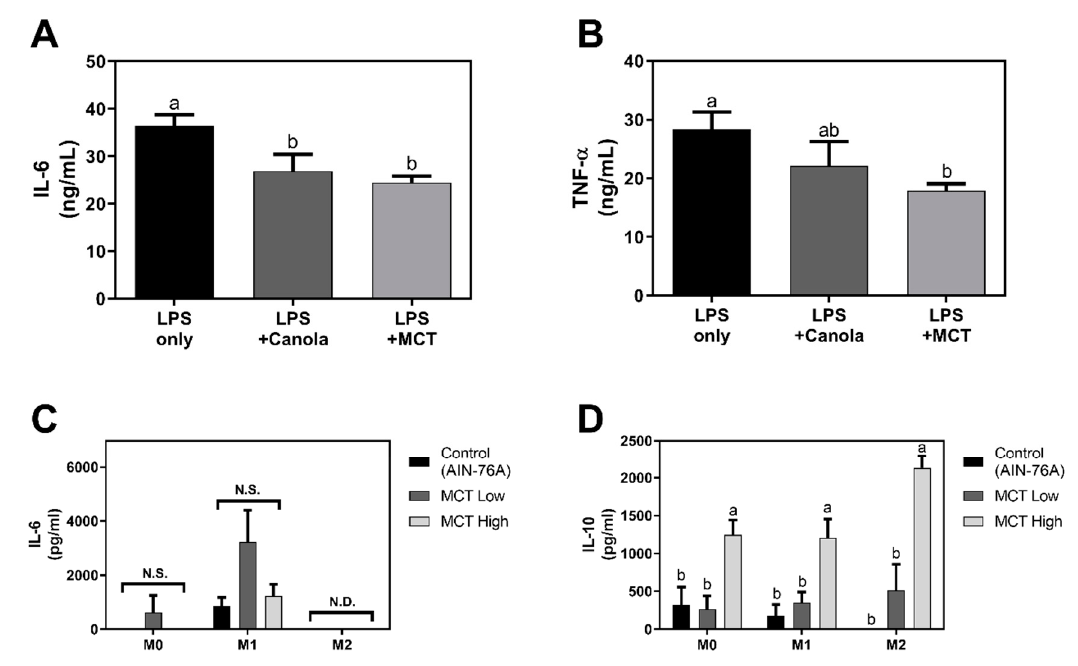
Figure 4. MCT inhibits the production of pro-inflammatory cytokines while enhancing anti-inflammatory cytokine secretion. IL-6 ( A ) and TNF- α ( B ) production of RAW 264.7 macrophages treated with conventional oil samples under LPS-stimulated conditions ( n = 3). Pro-inflammatory cytokine, IL-6 ( C ), and anti-inflammatory cytokine, IL-10 ( D ) secretion by mice BMDMs under non-polarized (M0), M1, and M2 polarized conditions ( n = 7). The quantification of cytokines in culture supernatants was determined by ELISA. Data are indicated as mean ± SEM, and statistical significance is presented with different letters ( p < 0.05, N.S. means no significant difference, N.D. means not detected) within each M0, M1, and M2 column (C,D).